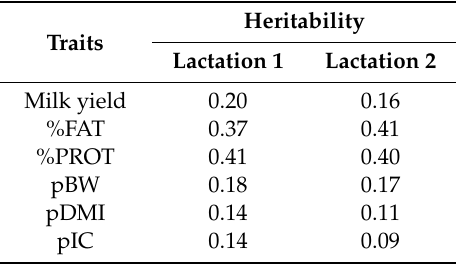
Table 3. Heritability (h 2 ) of studied traits for the first two